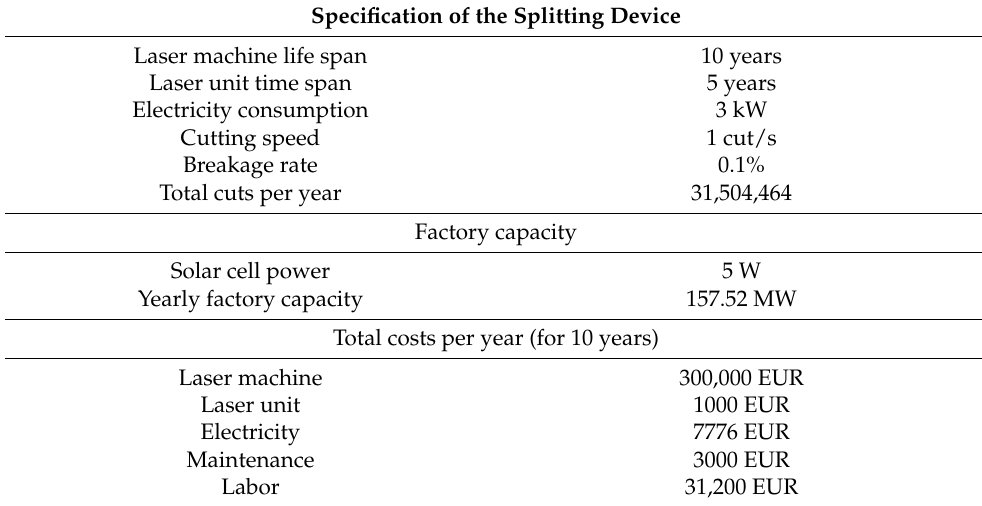
solar cell prices, are subject to rapid